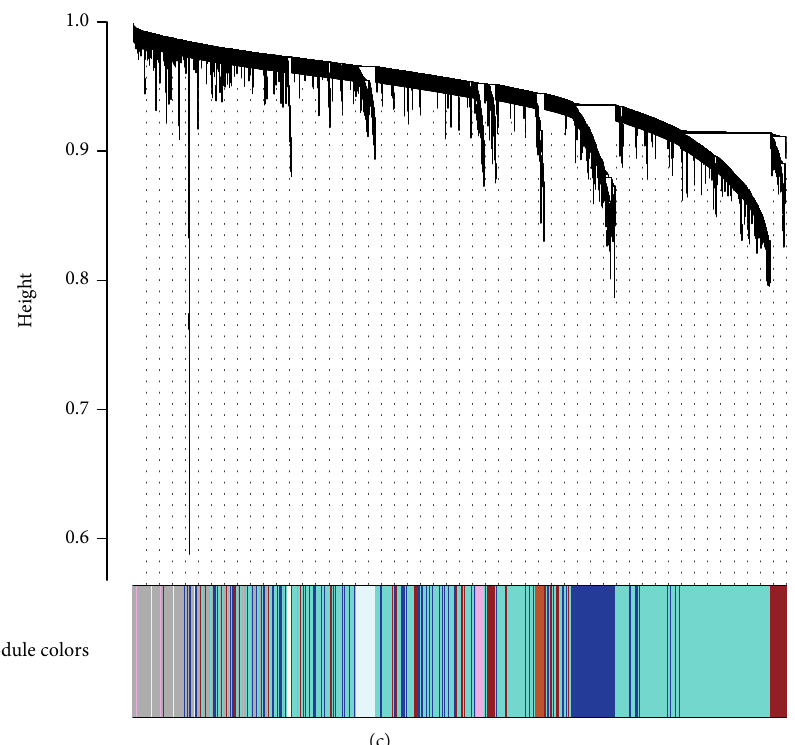
Figure 6: WGCNA in ND-IGT-T2D. (a) Analysis of network topology for various soft-thresholding powers. (b) Module – trait associations. Each row corresponds to a module, and each column corresponds to a trait. Each cell contains the corresponding correlation and p value. The table is color-coded by correlation according to the color legend. (c) Clustering dendrogram of genes, with dissimilarity based on topological overlap, together with assigned module